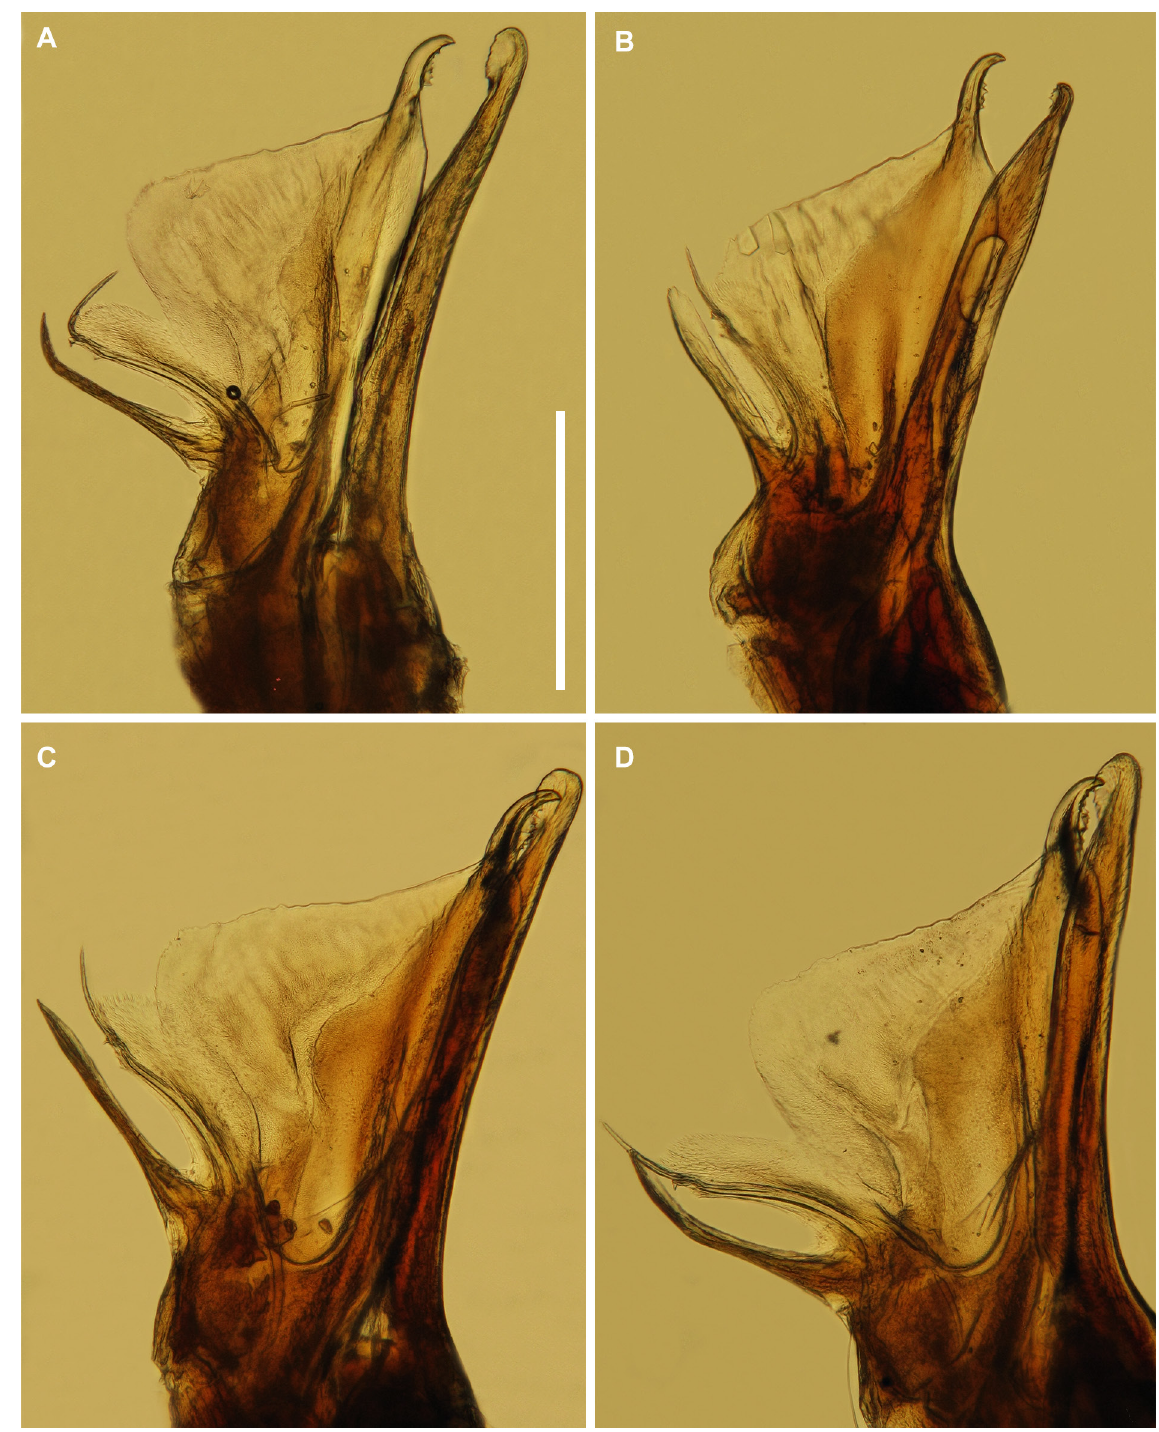
Fig. 6. Leucogeorgia abchasica (Lohmander, 1936) comb. nov., right gonopods, mesal views (ZMUM). A . ♂ from Dzykhayskaya I Cave. B . ♂ from Abraskila Cave. C . ♂ from Uatapachy Cave. D . ♂ from Samshitovaya Cave. Scale bar: 0.3